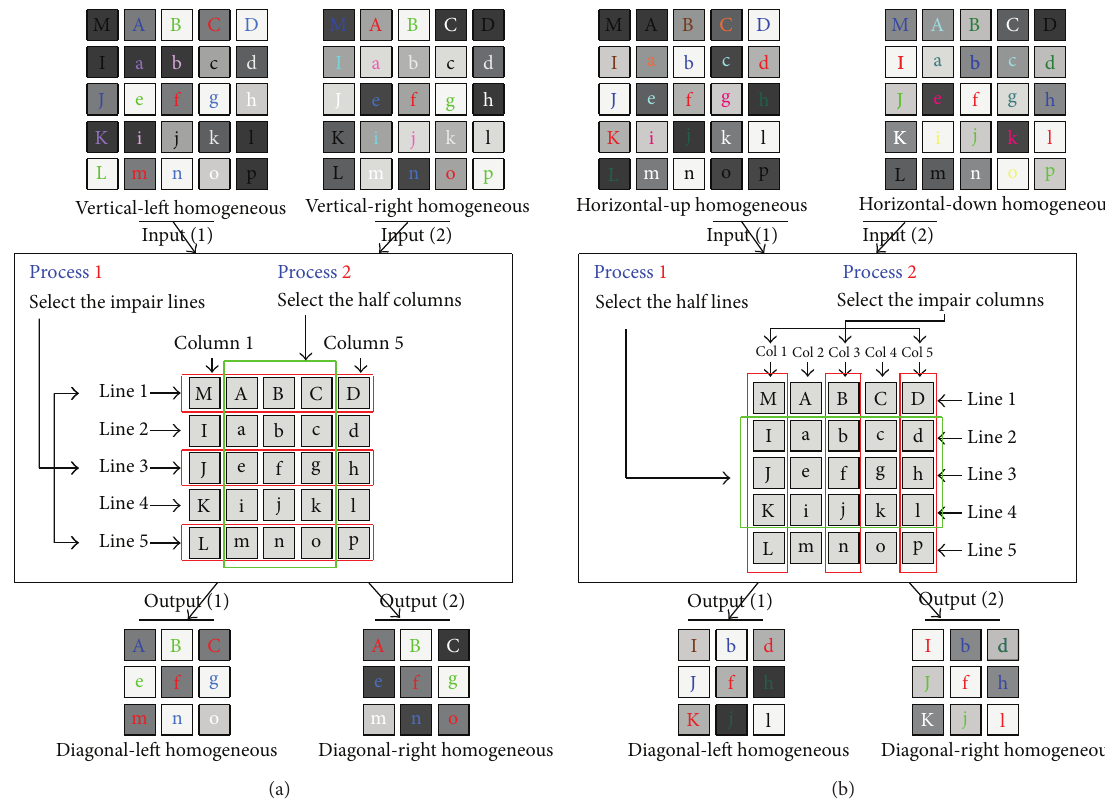
Figure 3: (a) The two 5 × 5 blocks and their corresponding square subblocks formed by ILHC method. (b) The two 5 × 5 blocks and their corresponding square subblocks formed by ICHL